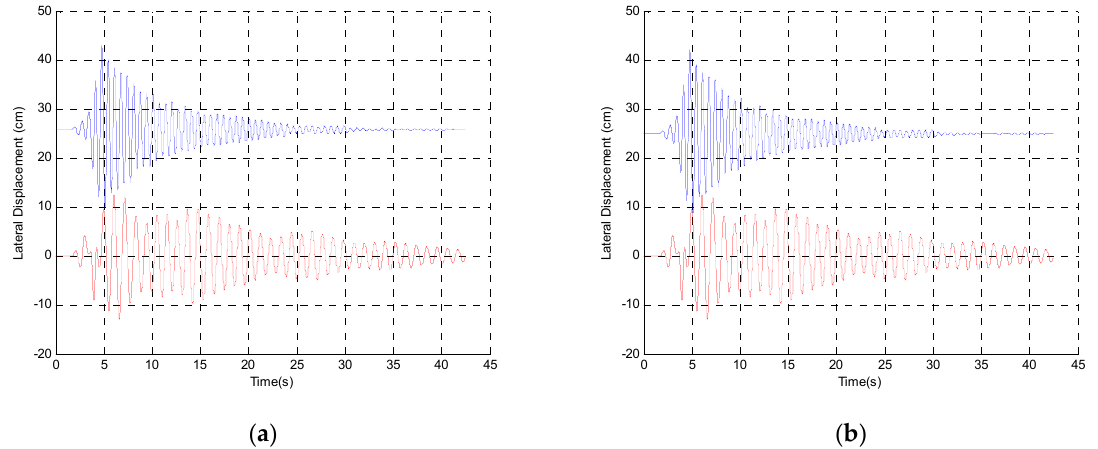
Figure 11. The lateral displacement time histories of buildings separated by the seismic gap, calculated by using Equation (2) and ( a ) Equation (9) or ( b ) Equation (10).